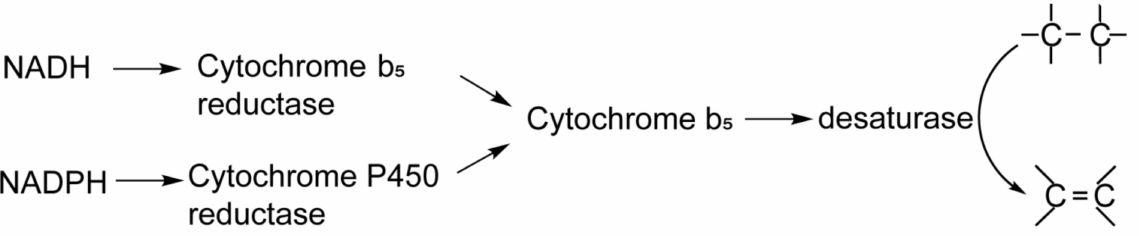
Figure 1. Schematic showing the two-electron transport